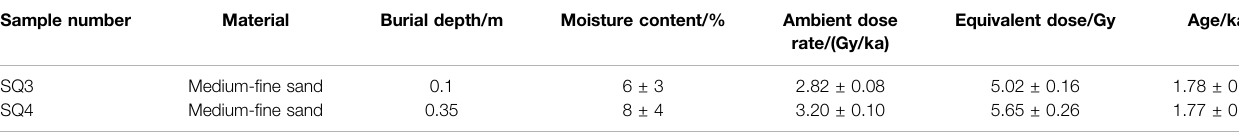
TABLE 1 | Results of OSL dating on the lacustrine sand.